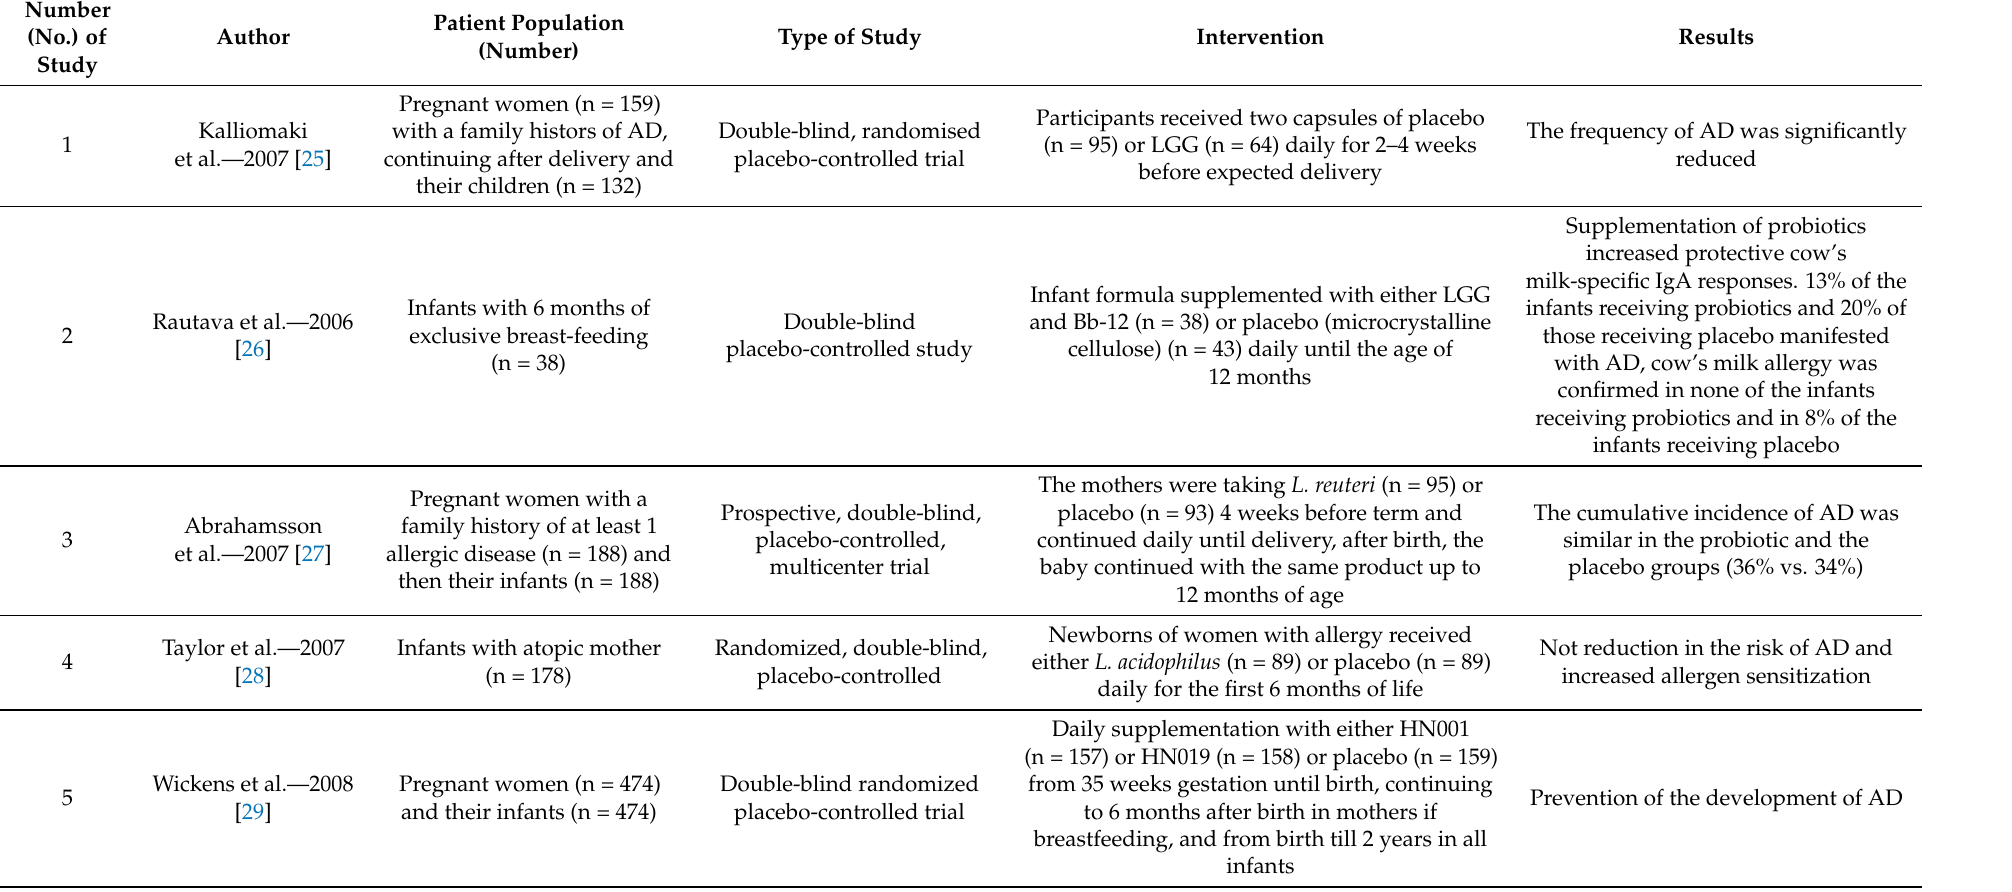
Table 1. Prebiotics in the prevention of